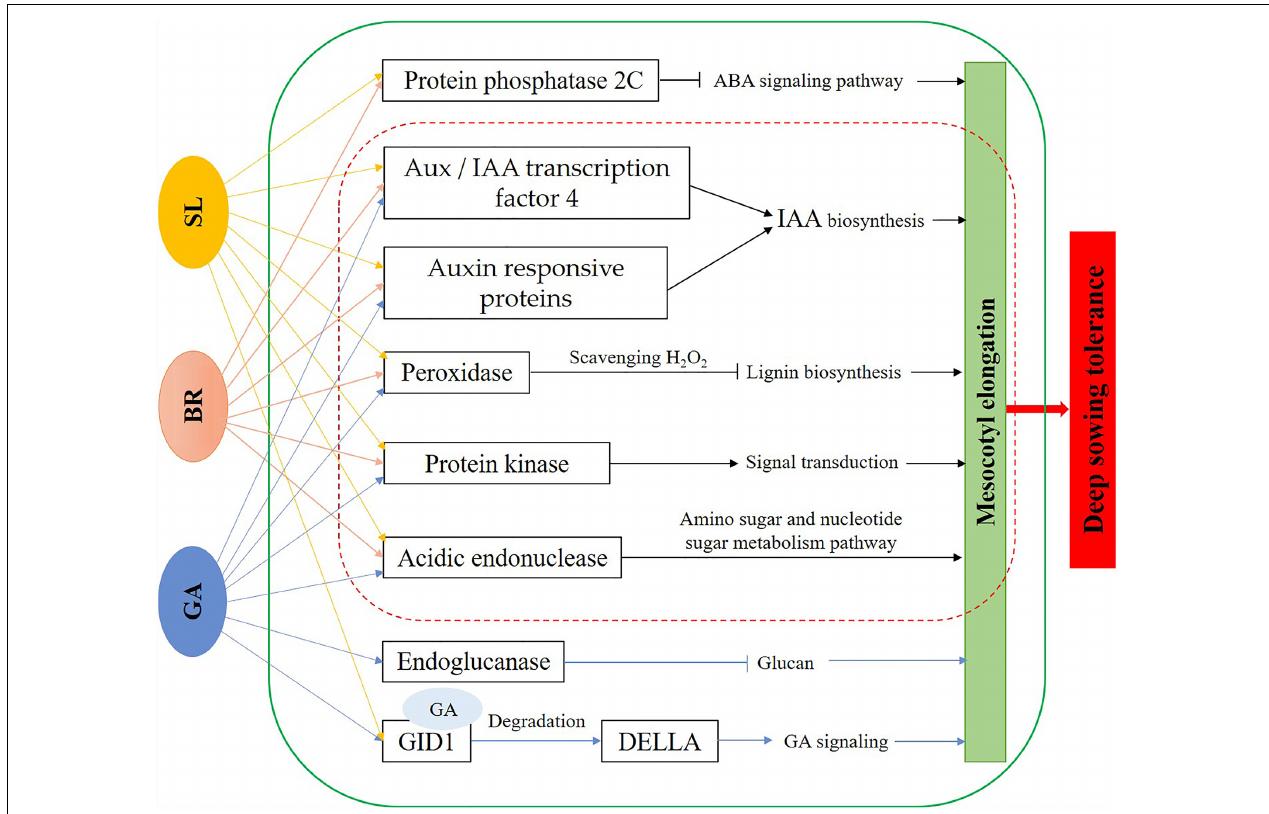
FIGURE 9 | Molecular model of the mechanisms underlying exogenous hormone regulation of deep sowing tolerance in maize seedling mesocotyls. GA, exogenous gibberellins; BR, exogenous brassinosteroids; SL, exogenous strigolactones.